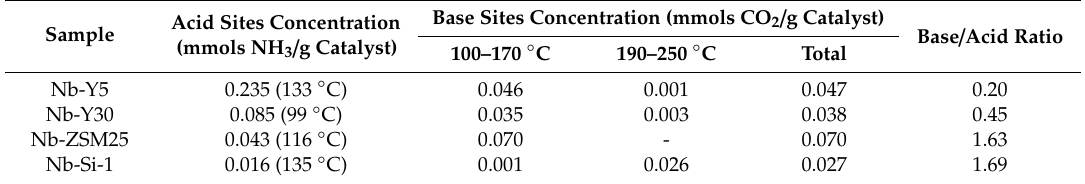
Table 2. Acid-base sites concentration determined through NH 3 - and CO 2